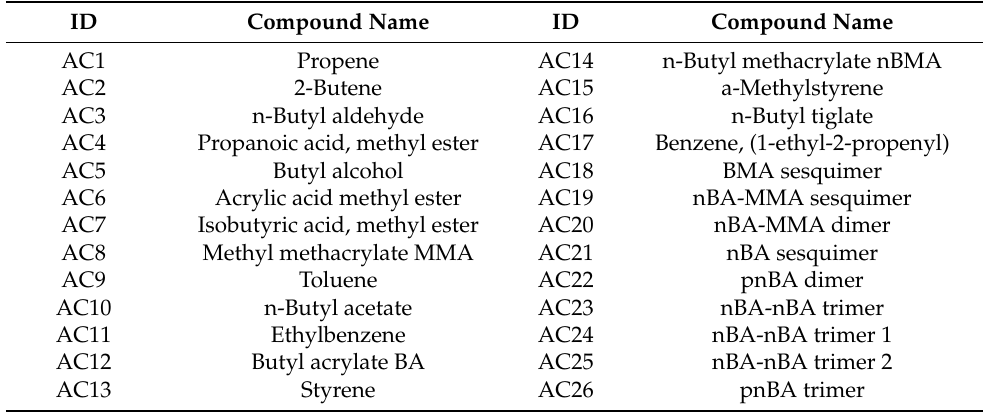
Table A2. List of all compounds identified in acrylic samples unaged and aged using Py-GC/MS and corresponding abbreviation used in data fusion